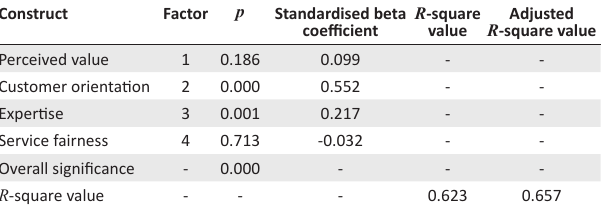
TABLE 7: Influence of the independent variables on calculative commitment. Construct